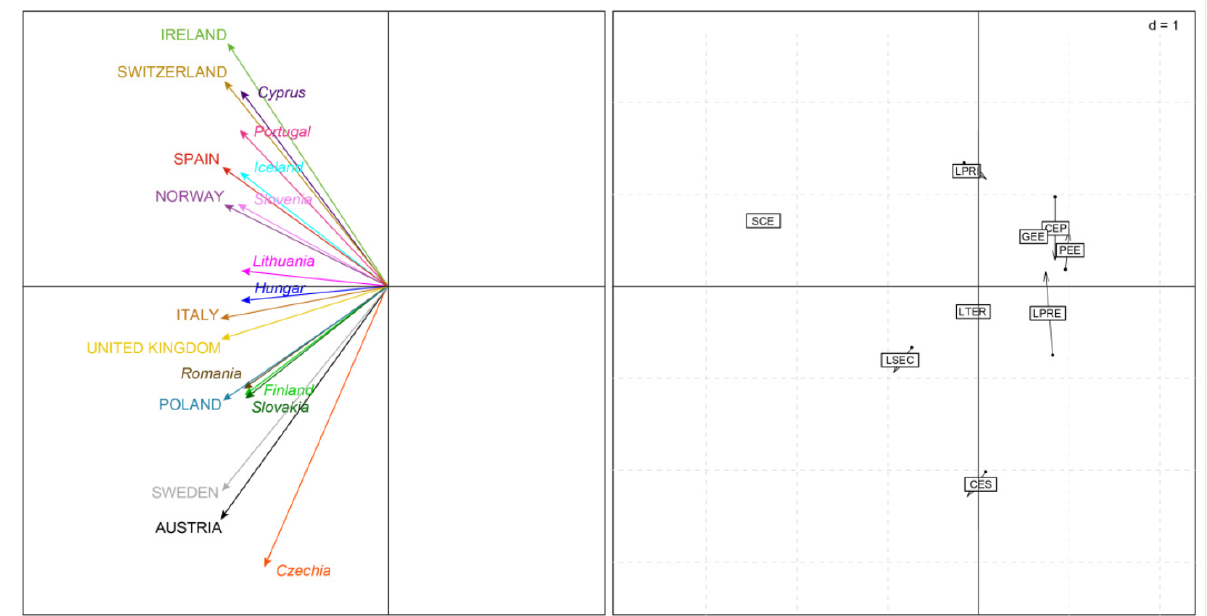
Figure 3. Graphs resulting from COSTATIS method: Euclidean representation of high and low-income countries’ compro- mises ( left ) and co-inertia analysis graph of the two compromises ( right ). The scale is given by the value d